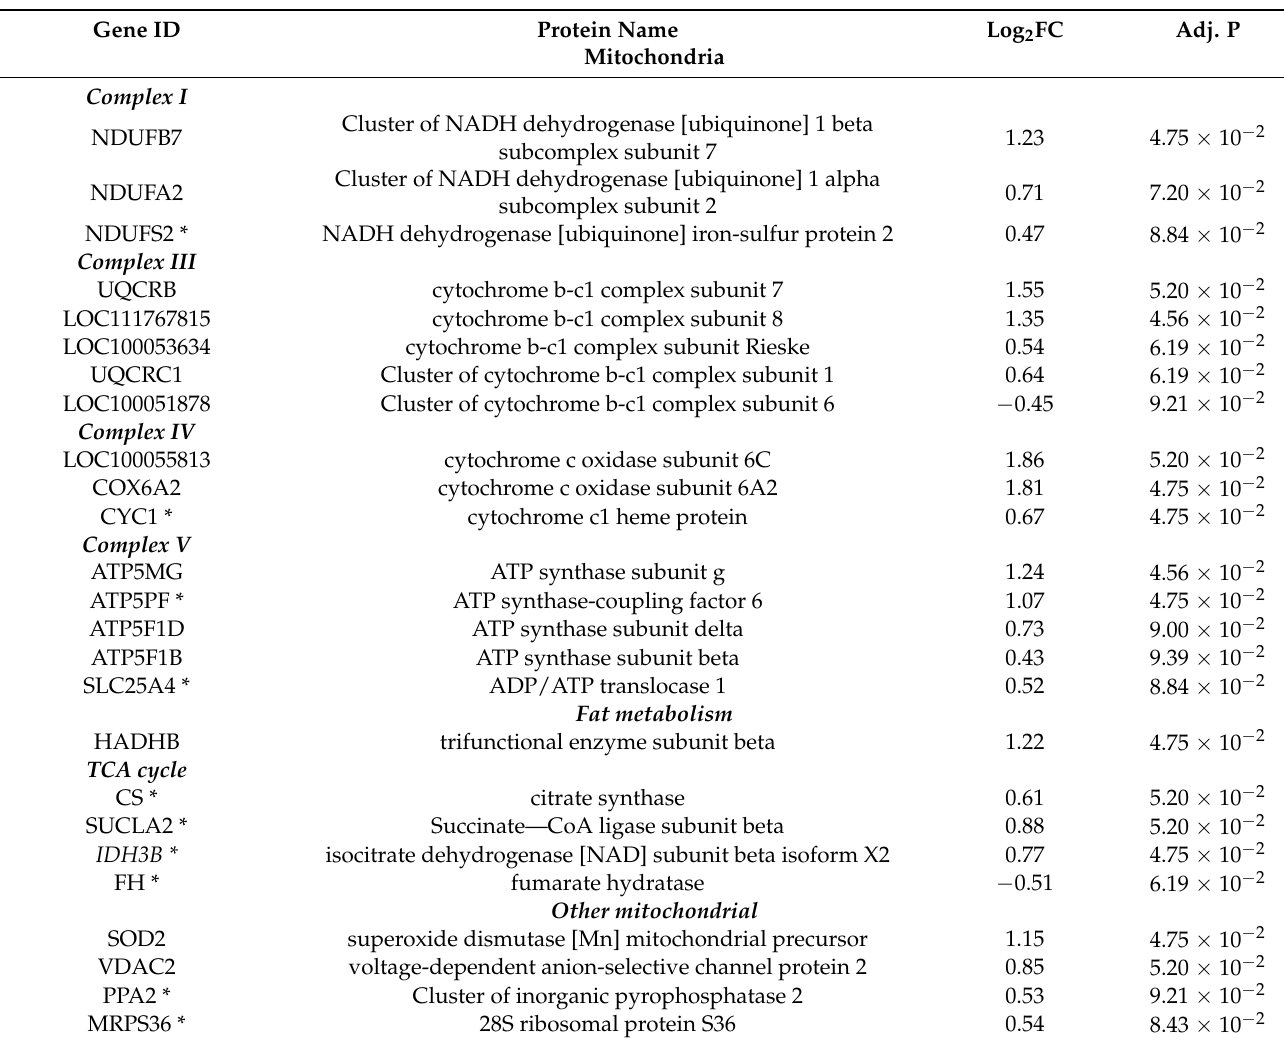
Table 3. Differentially expressed muscle proteins (DEP) in mitochondria of Standardbred horses susceptible to recurrent exertional rhabdomyolysis compared to control. Proteins are identified by their gene ID, protein name, and log 2 fold change (FC). p value adjusted for multiple comparisons (FDR < 0.10) are provided. An asterisk indicates those DEP that also had differentially expressed genes. * indicates DEP that were also differentially expressed